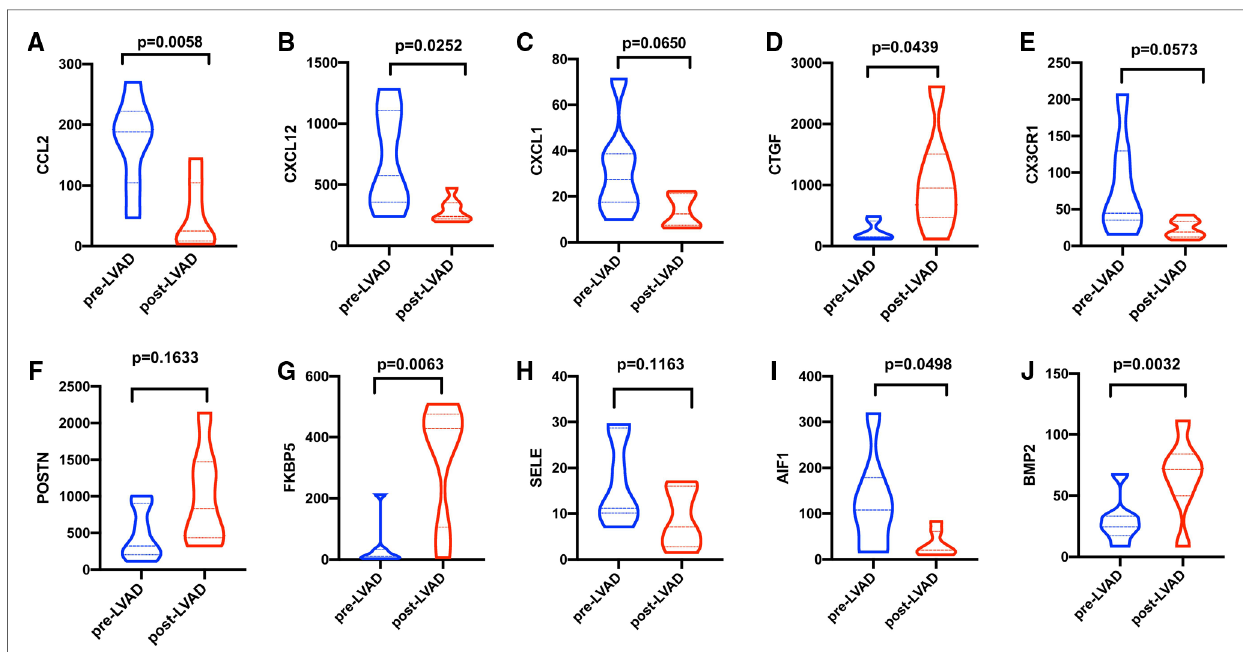
FIGURE 8 ( A – J ) Expressions of top 10 hub genes between pre-LVAD and post-LVAD groups in GSE430. The blue ones were pre-LVAD groups. The red ones were post-LVAD groups.